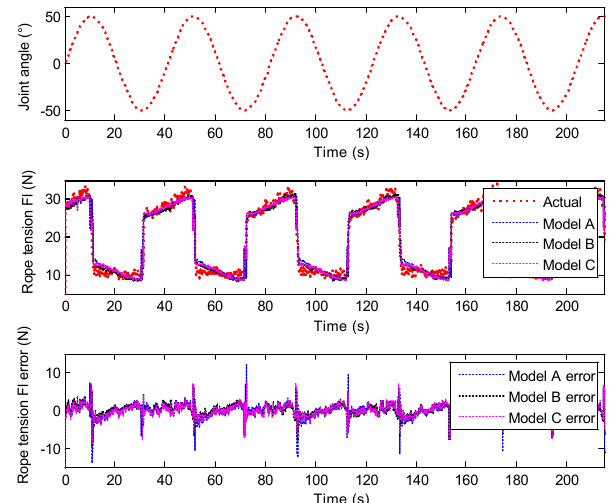
Figure 16. The identification results and the identification errors of the three models.